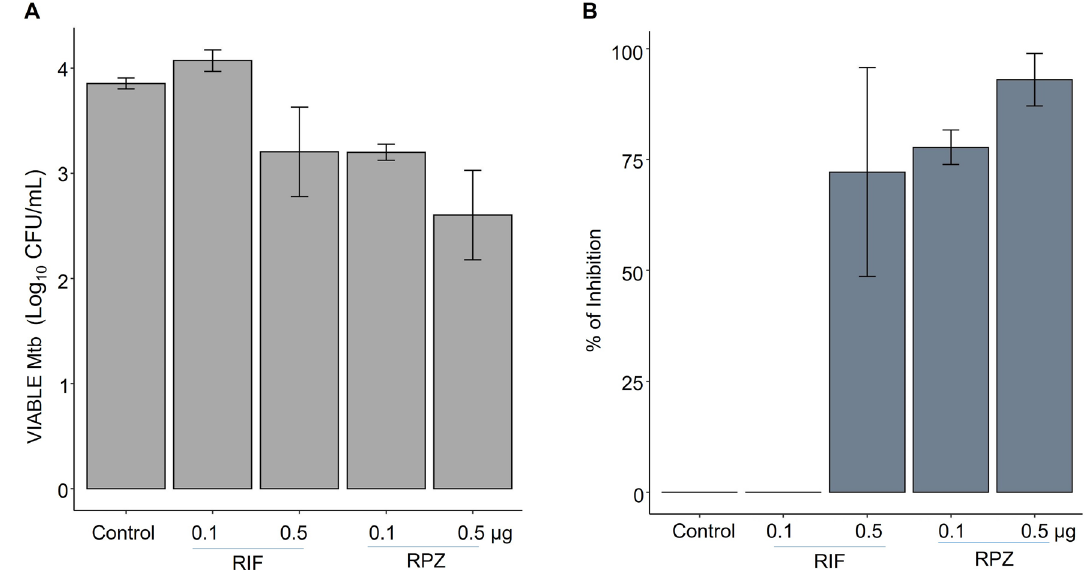
Figure 2. The in-vitro anti-TB activity of drugs against Mtb strain H37Rv . ( A ) The remaining Mtb (CFU) left over after treatment with RPZ and control drug RIF are shown in this graph. ( B ) The plot shows % of Inhibition of Mtb H37Rv by RPZ. Results are mean of the vertical bars represent ± SD of two experiments. The difference in the number of CFU between RIF 0.5 VS RPZ 0.5, RIF 0.5 VS RPZ 0.1 and RPZ 0.5 VS RPZ 0.1 were statistically significant. (P < 0.001). The statistical analyses were performed using R software version 3.6.1 (R Core Team (2019). R: A language and environment for statistical computing. R Foundation for Statistical Computing, Vienna, Austria. URL https ://www.R-proje ct.org/).